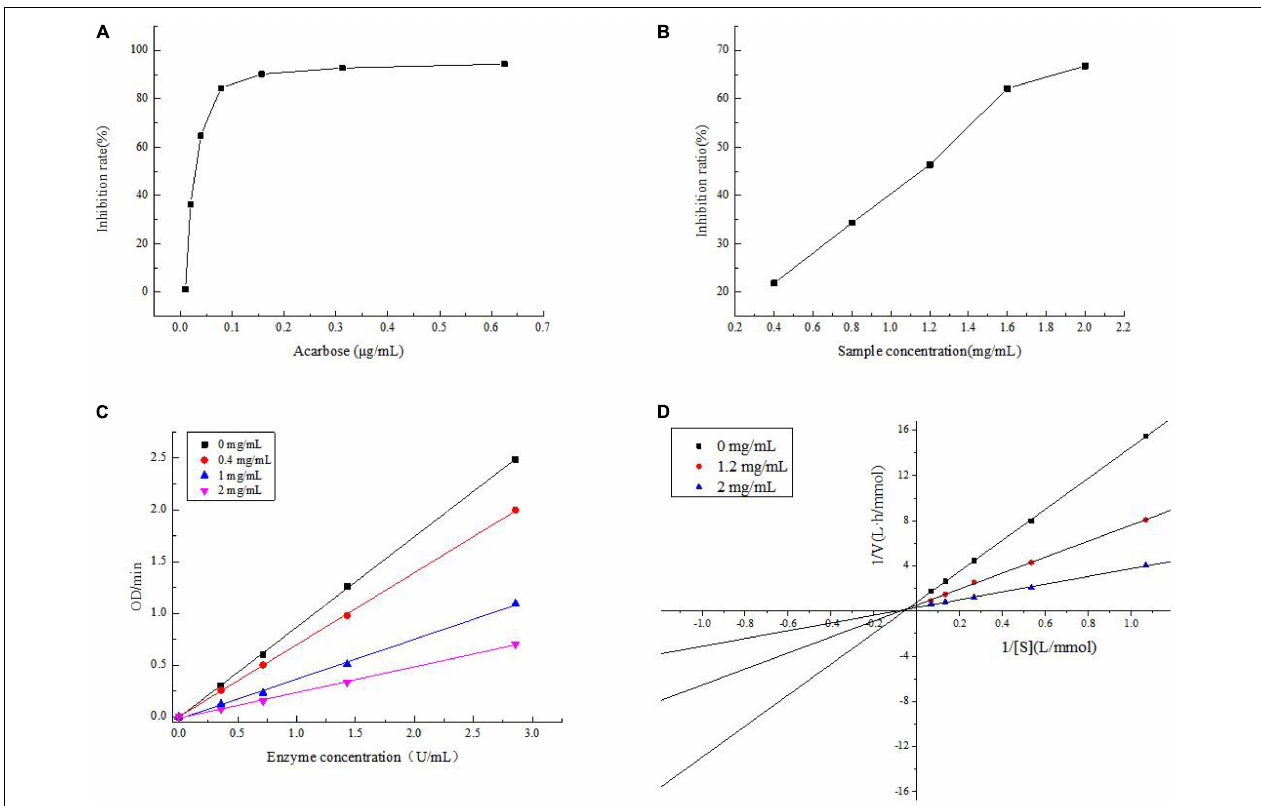
FIGURE 6 | (A) Inhibition on the α -glucosidase activity of acarbose; (B) inhibition on the α -glucosidase activity of JCH-a1; (C) inhibition kinetic diagram of JCH-a1; (D) lineweaver-Burk plots for a-glucosidase inhibition by JCH-a1.